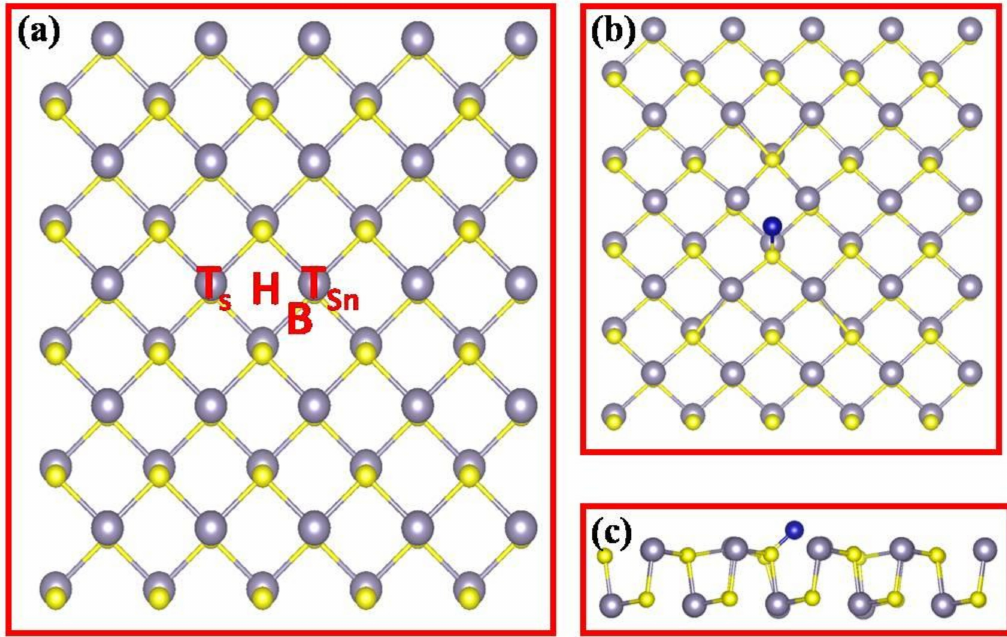
Figure 2. ( a ) Four possible sites of transitional metal atoms doping on 2D SnS pristine monolayer: the top site of a S atom (T S ) or on a Sn atom (T Sn ), the bridge site over a S-Sn bond ( b ), and the hollow site of a hexagon ring (H); ( b ) The top view of the most stable state; ( c ) The side view of the most stable